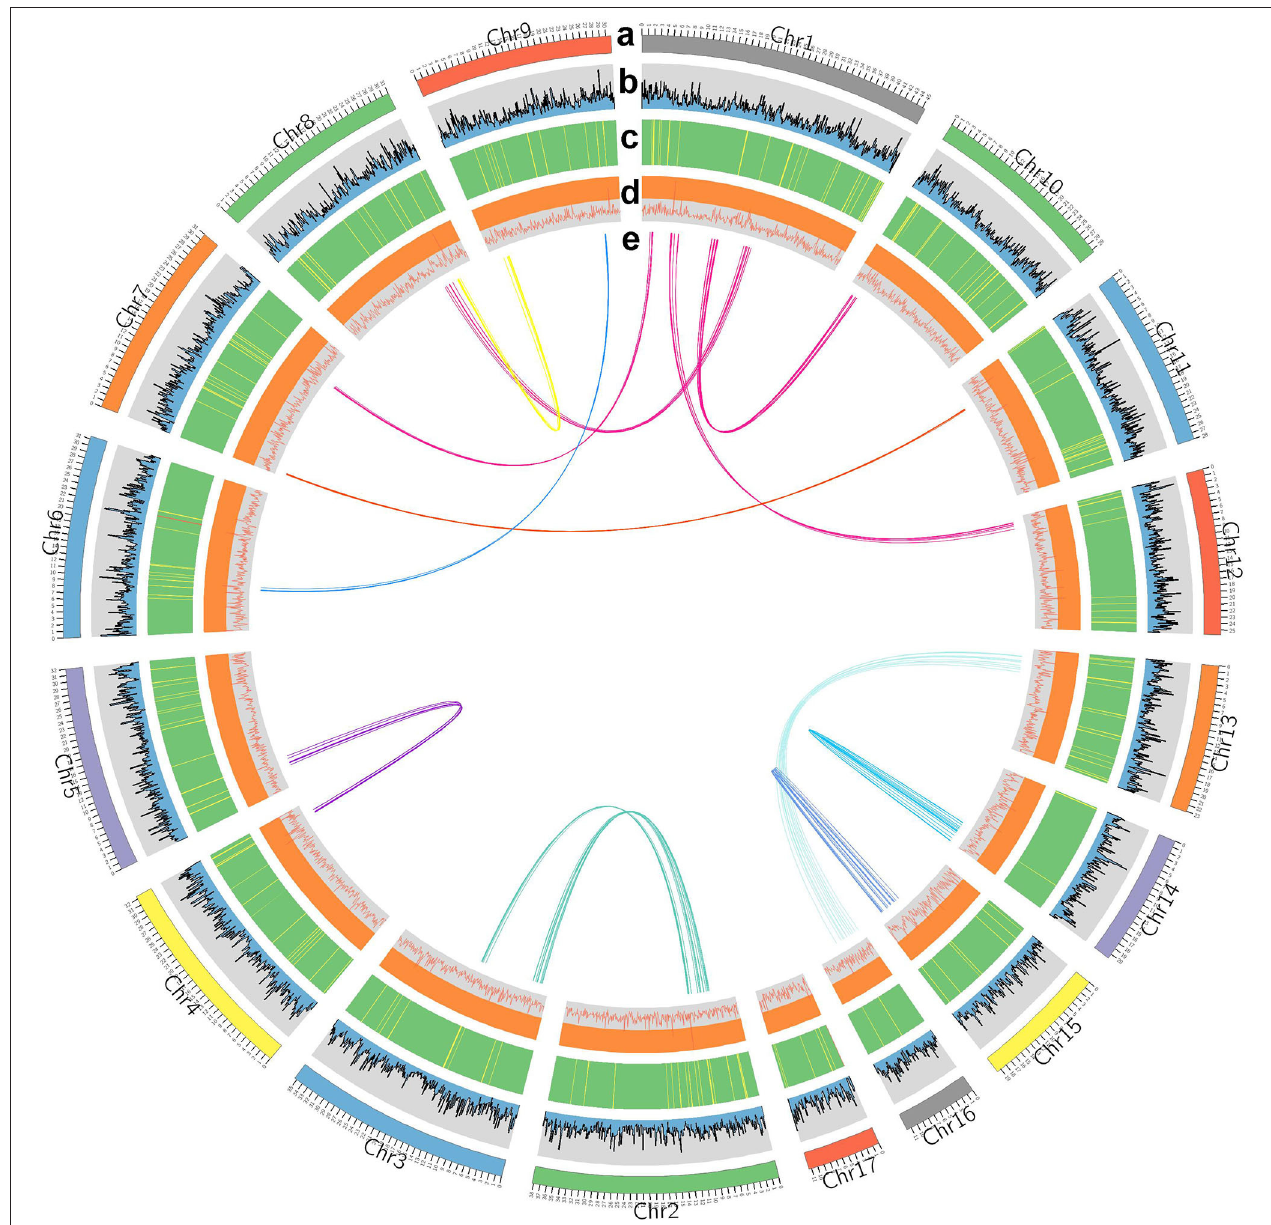
FIGURE 2 | Characterization of Capitulum mitella. Genome elements are arranged in the Circos plot. (a) Eight assembled chromosomes of the genome. (b) The distribution of GC content. (c) Distribution of gene density (green). (d) Statistics for coverage of TEs. (e) Circos diagram of major interchromosomal relationships in the C. mitella genome. Each line represents a syntenic block; block size = 3kb.